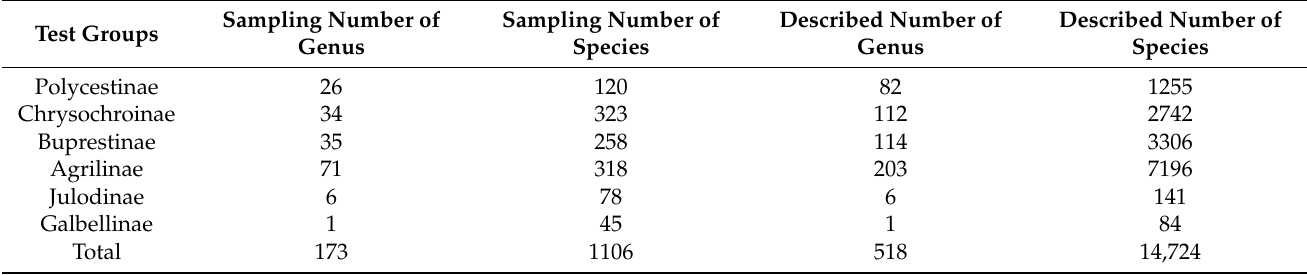
Table 1. Sampling/described information of test subfamilies.